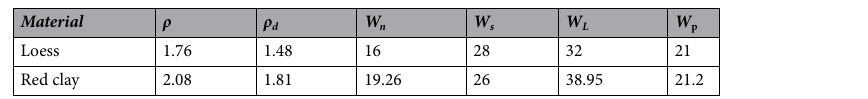
Table 1. Physical parameters of Lishi loess used in the test. ρ = Natural density (g/cm 3 ); ρ d = Dry density (g/